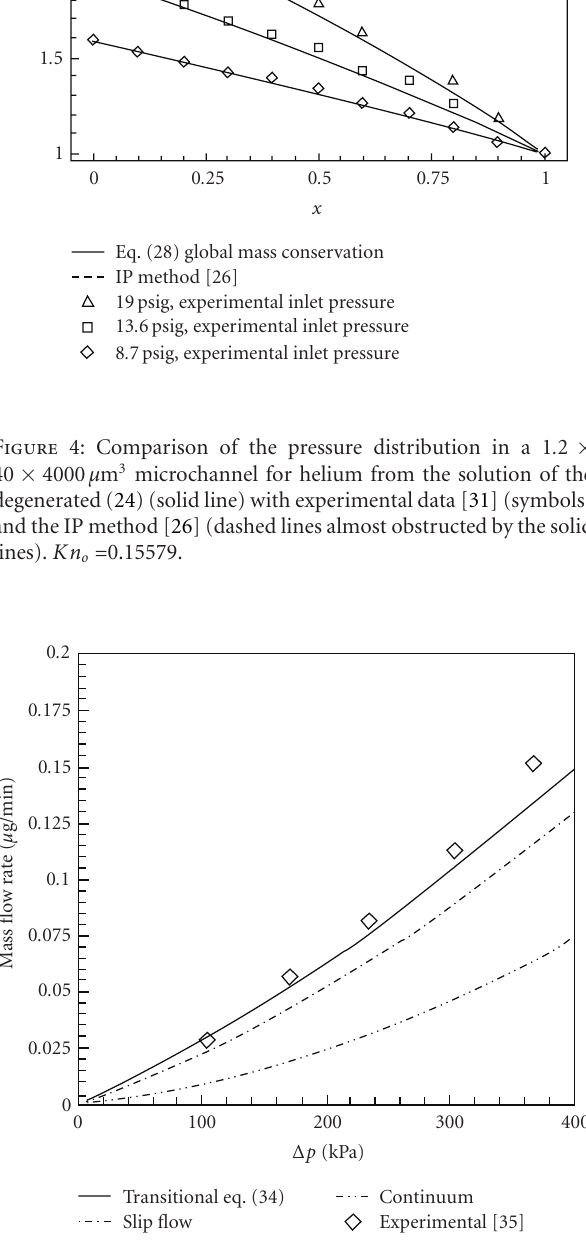
Figure 5: Comparison of the mass flow rate obtained from global mass conservation, transitional flow, (30) (solid line), slip flow (dash-dot line), and continuum (dash-dot-dot line) with experimental data in a 0 . 53 × 40 × 4000 μ m 3 microchannel for helium [35] (symbols) at Kn o = 0 . 3684